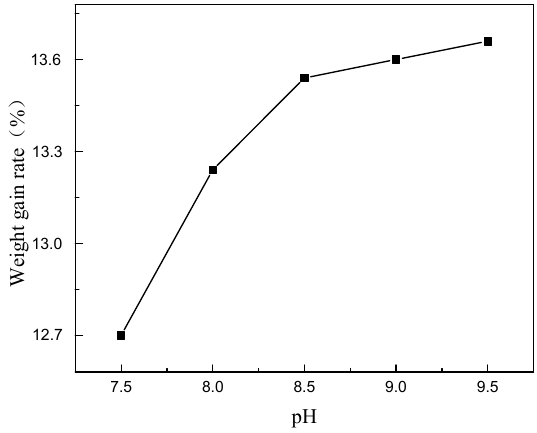
Figure 5. Effect of pH value on the weight gain rate.